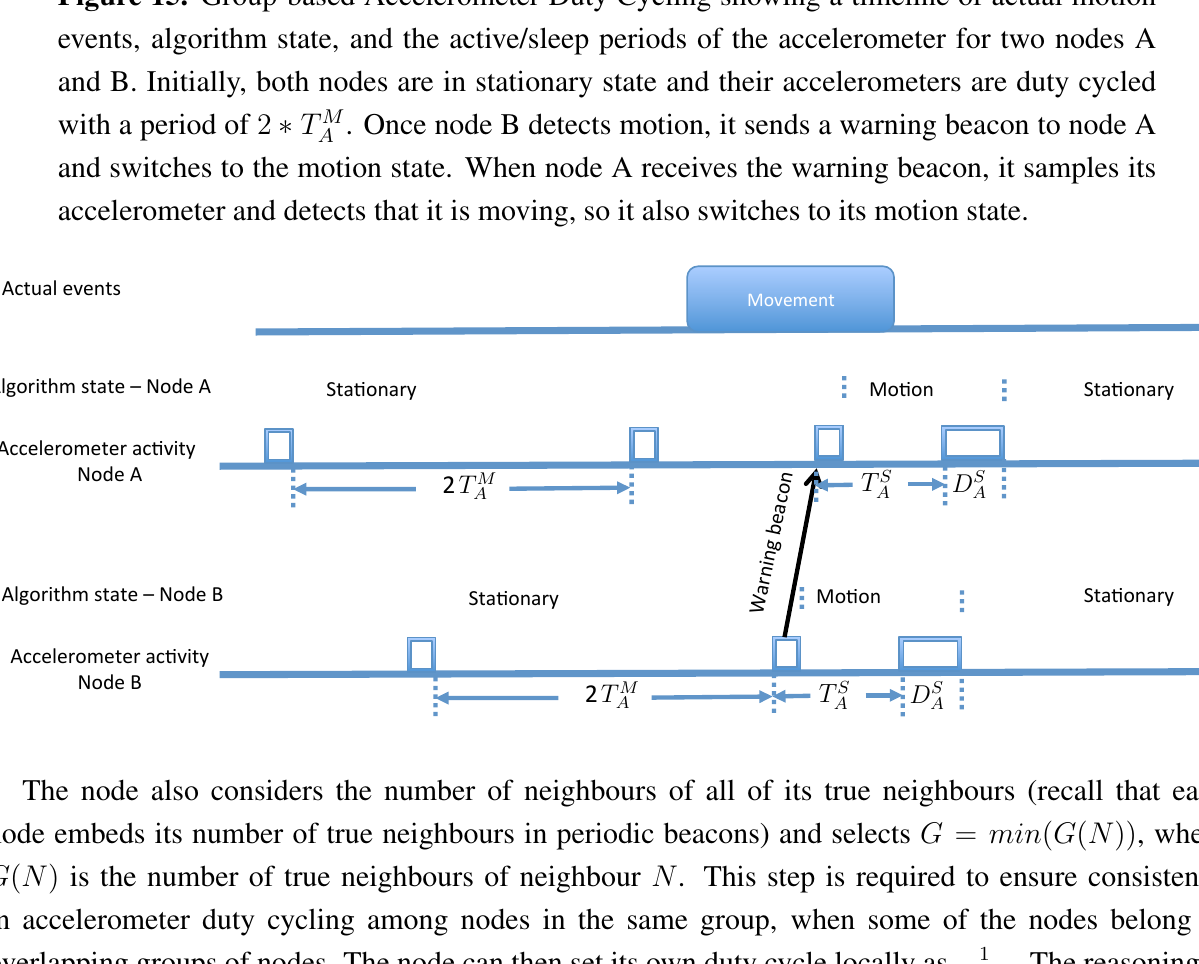
10 of 31 Figure 5. Accelerometer Individual Duty Cycling Strategy loop { event handler(Event event) } if event==GPS LOCKED then U= U gps turn GPS OFF turn Accelerometer ON send Radio beacon (GPS